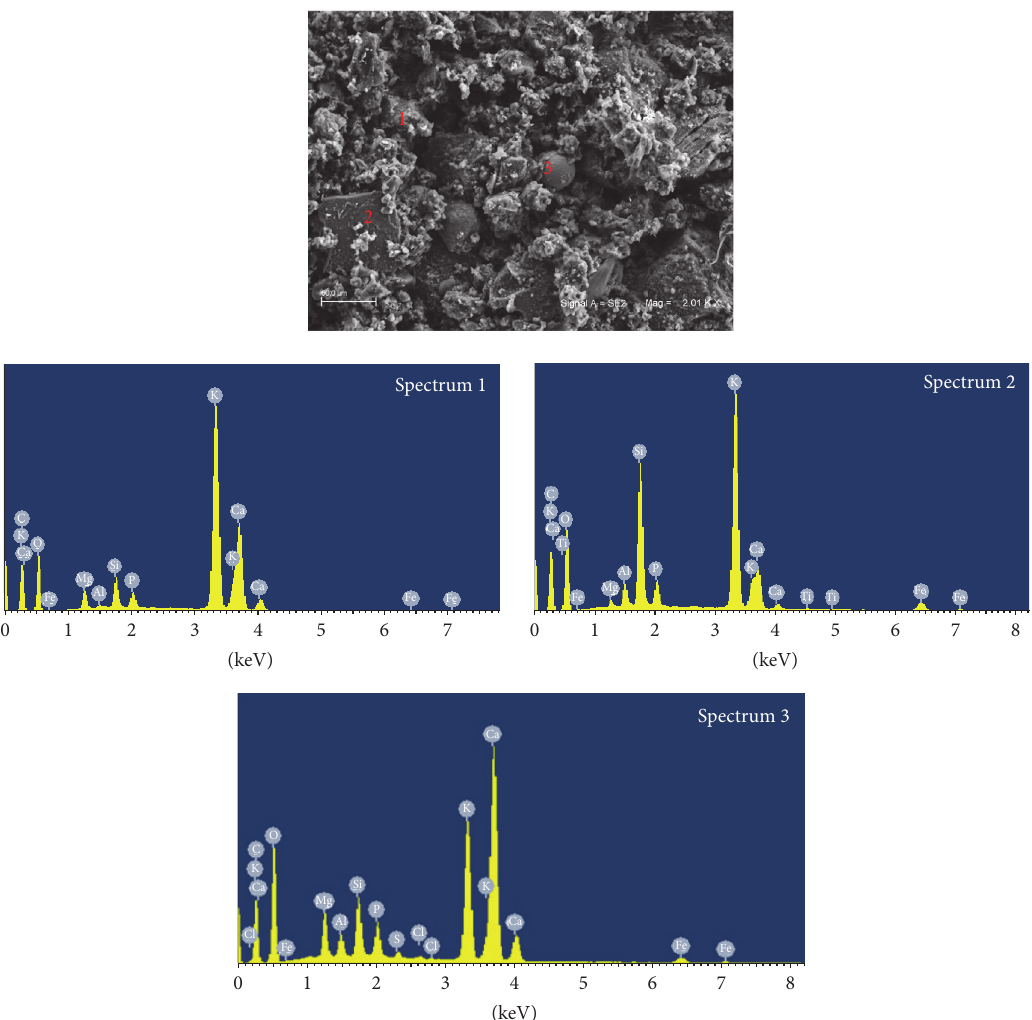
Figure 2: SEM/EDX of olive stone as used as raw material for clay